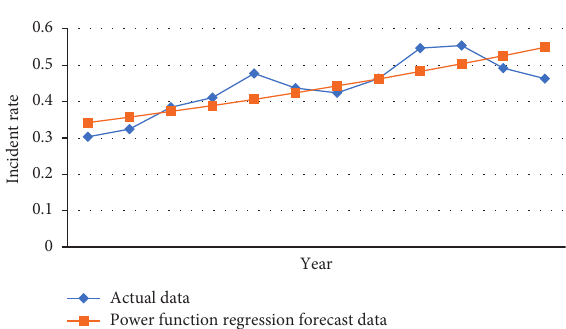
Figure 1: Comparison of power function regression forecast data and actual